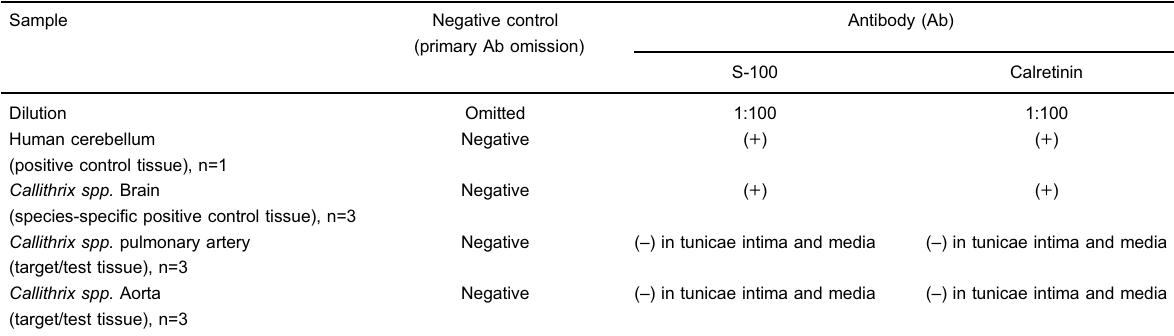
Table 1. Immunohistochemical detection of S-100 protein and calretinin in Callithrix spp. (marmoset) brain, pulmonary artery, and thoracic aorta.